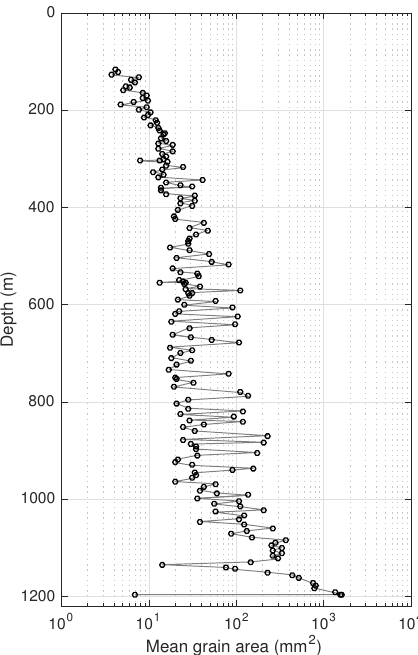
Figure 3. Variation in the DSS ice core mean grain area with actual depth. See text for details of the mean grain area calculation. All values were determined from horizontal thin sections (after Li et al., 1998).